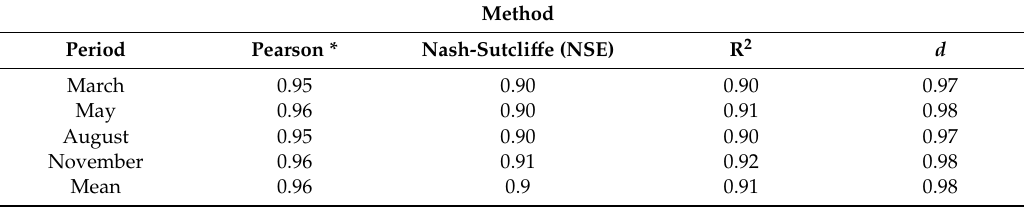
Table 2. Statistical analysis of data predicted x simulated by the model for